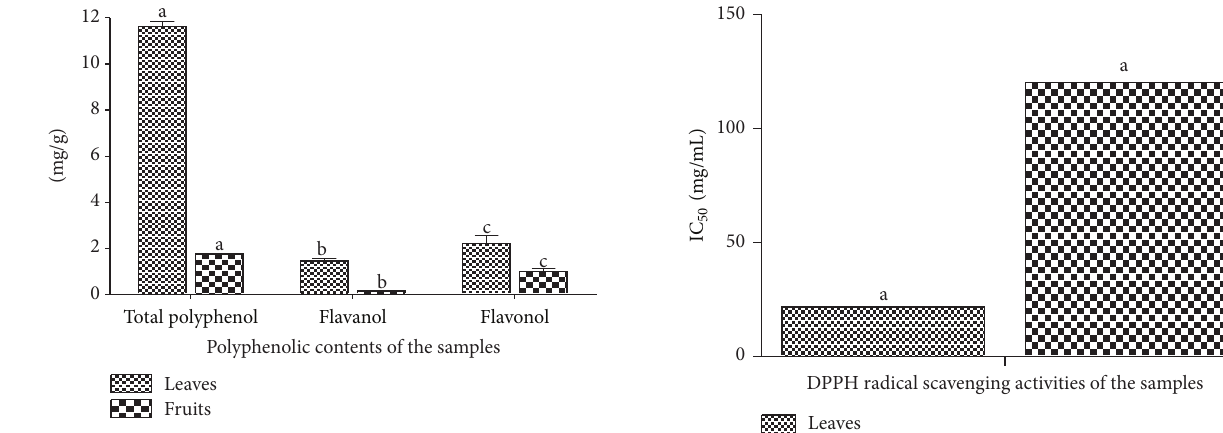
Figure 3: Total polyphenol, flavanol, and flavonol contents in the aqueous extracts of the leaves and fruits of Nauclea latifolia. All significant differences are at 𝑃 < 0.05 . a-a,b-b,c-c Bars having the same alphabets are significantly different from each other.